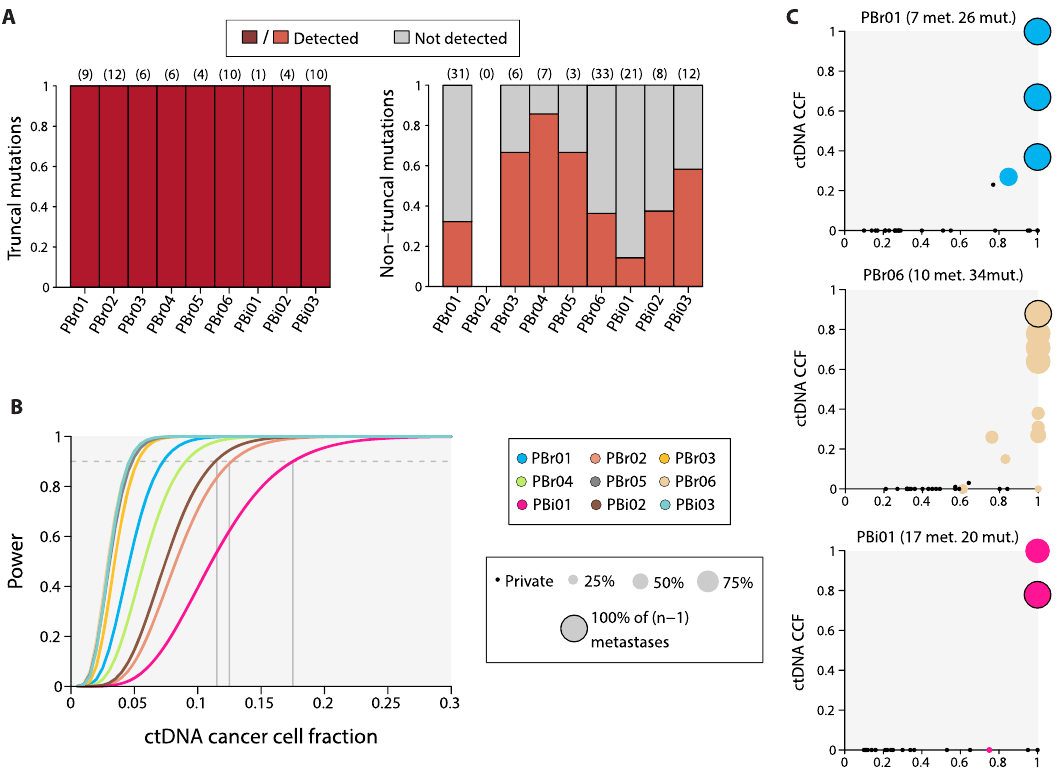
Fig. 4 Detection of tissue mutations in cfDNA. A Proportions of trunk (left) and non-trunk (right) mutations, as classi fi ed using tissue samples, that were detected in cfDNA. The numbers of truncal mutations falling within the panel of 566 genes are shown above the bars. There were no branch mutations within the panel for PBr02. B Power curves for the detection of point mutations present in a range of ctDNA cancer cell fractions (CCF) are shown for the nine samples (colors correspond to those in Fig. 3). Power to detect point mutations depends on tumor fraction, depth of coverage, and estimated ploidy. The medium depth of coverage across all loci where a branch or private mutation was observed in tissue, but not in cfDNA was used for the calculation. The minimum ctDNA CCFs for which 90% power was achieved are indicated. C Representation of private (black points) and branch (colored circles) mutations in cfDNA. The CCF in which mutations were observed in ctDNA was in fl uenced primarily by the number of tissue lesions, in which the mutation was detected (circle sizes), with the maximum CCF across all tissue samples having a lower effect. Only sSNVs were considered for analyses involving CCF estimation due to the dif fi culty of reliably estimating depth and VAF for somatic indels. The three samples with at least 20 branch and private mutations are shown. Met number of metastases, mut number of non-truncal mutations shown in the Tissue samples versus cfDNA for biomarker detection . For patients with metastatic disease on treatment, molecular testing using cfDNA or tissue biopsies is often used to help determined the next line of therapy. However, the sensitivity of cfDNA relative to tissue biopsies for detecting all clinically relevant mutations is unclear. The relative utility of cfDNA to determine mutation truncality has also not been demonstrated.